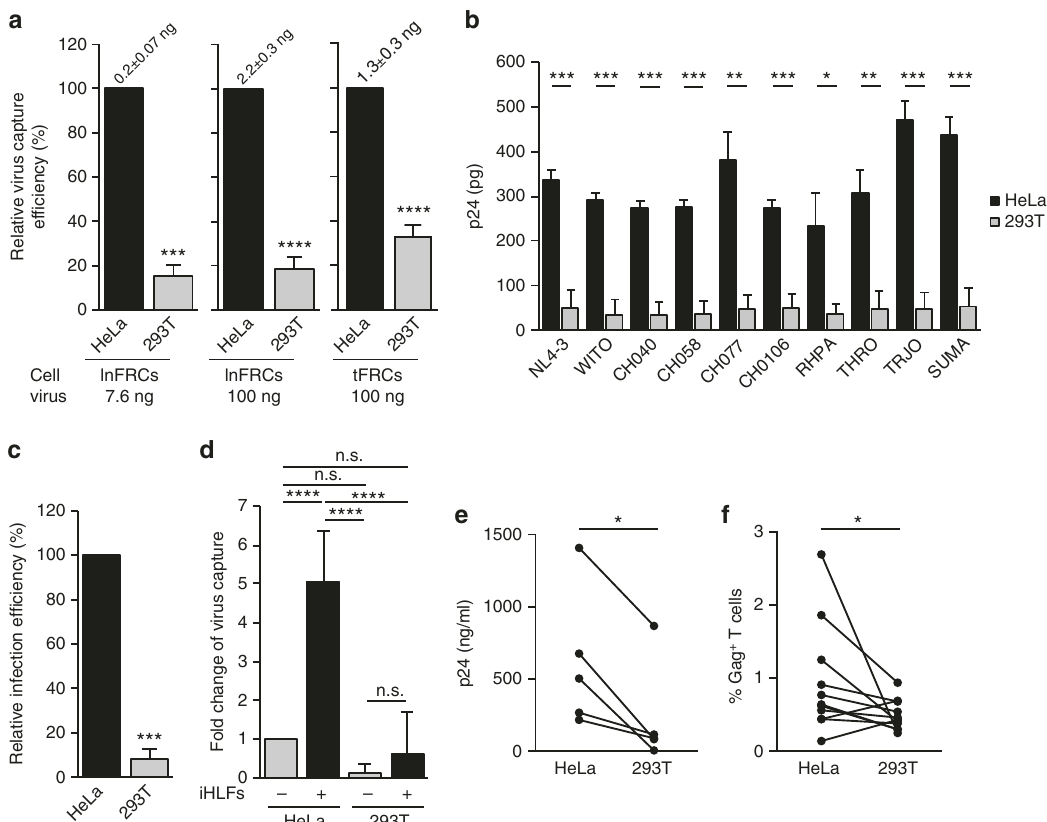
Fig. 5 FRCs mediate trans-infection in two-dimensional and three-dimensional culture systems in a manner dependent on virus producer cell types. The input viruses were produced using HeLa and 293T cells and compared using the same amount (based on the p24 amount). a Quanti fi cation of the amount of HIV-1 NL4-3 captured by lnFRCs and tFRCs. lnFRCs and tFRCs were cultured in the presence of the indicated amount of HIV-1 NL4-3 for 2 h and washed extensively. The amount of virus captured by lnFRCs and tFRCs was quanti fi ed by p24 ELISA assays. Relative virus capture ef fi ciency is calculated in comparison with the amount of HeLa-derived virus captured by lnFRCs or tFRCs in each experiment. Absolute amounts of captured HeLa-derived virus are shown above the black bars. b Quanti fi cation of the amount of transmitted/founder viruses captured by lnFRCs. For inoculation, 7.6 ng p24 of viruses were used. c Comparison of ef fi ciencies of trans-infection of A3.01 T cells mediated by lnFRCs. Performed as in Fig. 1. d Comparison of virus capture ef fi ciencies in a 3D culture system encapsulating ilnFRCs. PEG gels encapsulating either ilnFRCs or no cells were pulsed with HeLa- and 293T-derived HIV-1 NL4-3 (7.6 ng p24) for 16 h and washed extensively. The gels were further cultured for 4 h and washed with RPMI-10 twice. The gels were solubilized, and the